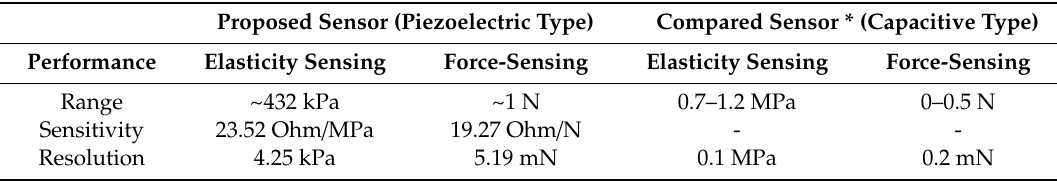
Figure 8. Force-sensing test result using the 6 × 6 sensor array; ( a ) 2 N ( b ) 3 N, and ( c ) 4 N forces were applied. Red dotted squares indicate the area over which forces were applied. Table 2. Sensing performance comparison for the proposed